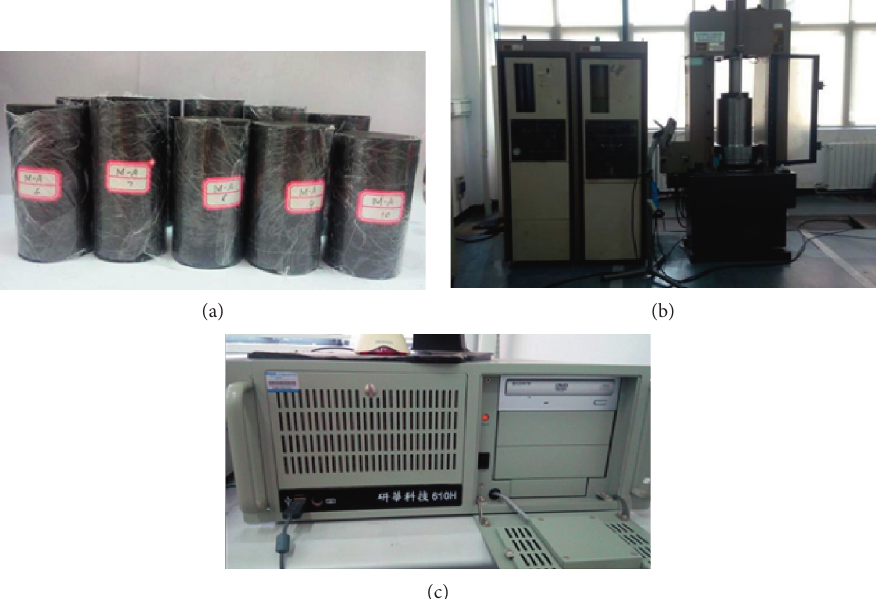
Figure 1: Standard coal samples and test equipment. (a) Standard coal samples, (b) MTS815.02 electrohydraulic servo rock mechanics test system, and (c) PCI-2 acoustic emission detection and analysis system.